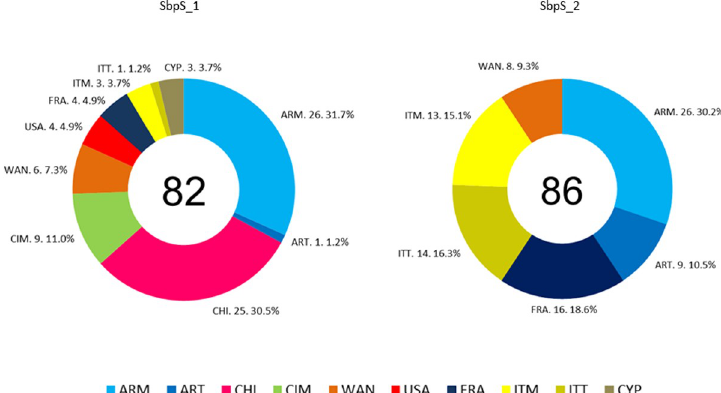
Fig 2. Ring graph showing the origin of accessions included in each subpopulation according to STRUCTURE analysis ( K = 2, maximum) using 26 SNP. The accessions are coded as ARM, modern Argentinians; ART, traditional Argentinians; CHI, Chile; CIM, CIMMYT; CYP, Cyprus; FRA, France; ITM, modern Italians; ITT, traditional Italians; USA, United States; WAN, West Asia North Africa region. Accessions from Argentina and Italy were divided in two groups according to the year of release (until and after 1985). It was considered "traditional" accessions to those bred or released before or up to 1985.